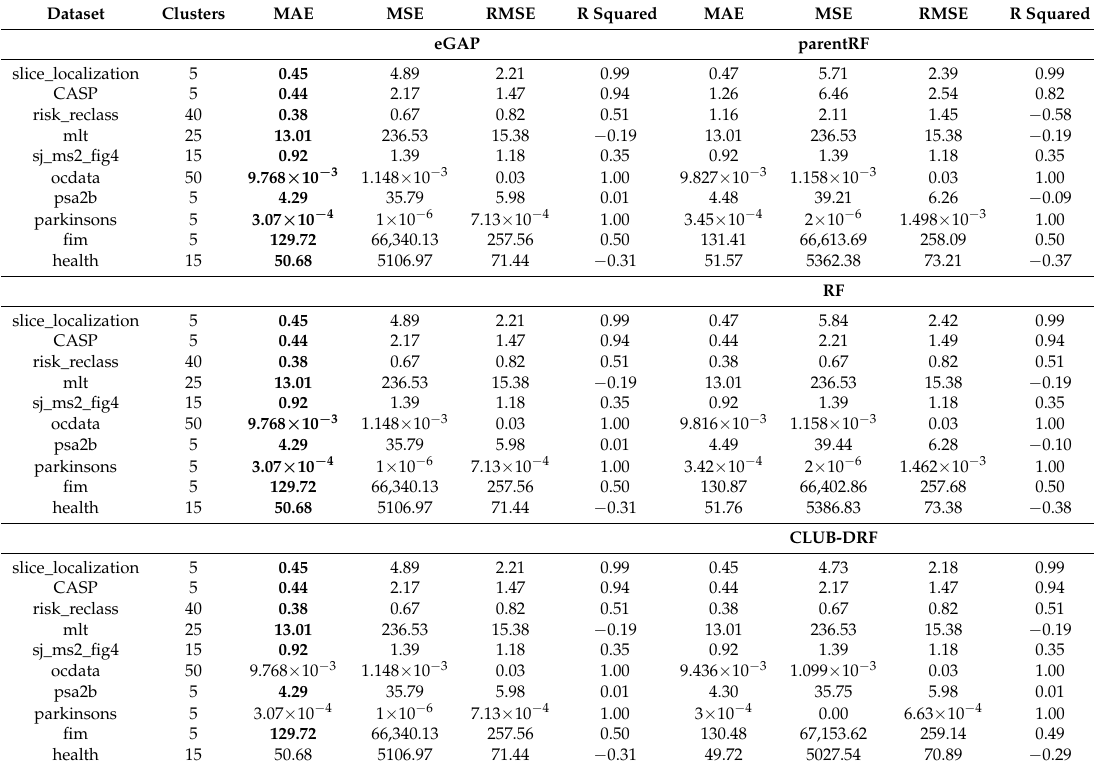
Table 7. Performance metrics of eGAP vs. parentRF, RF, and CLUB-DRF on regression datasets. (Figures in bold indicate the lowest